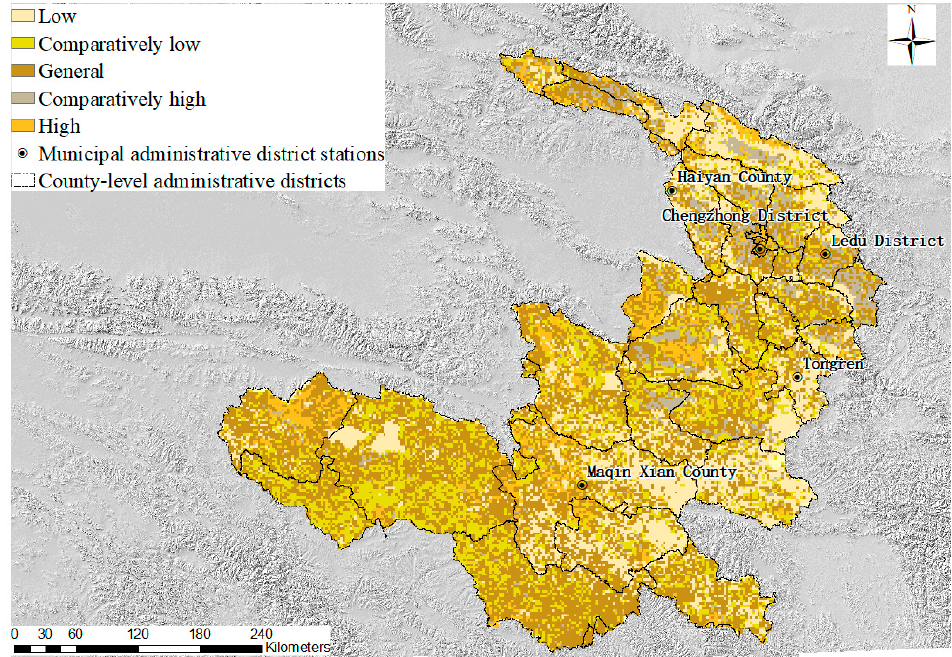
Figure 7. Distribution map of ecological risks of mining in the source area of the Yellow River Basin.